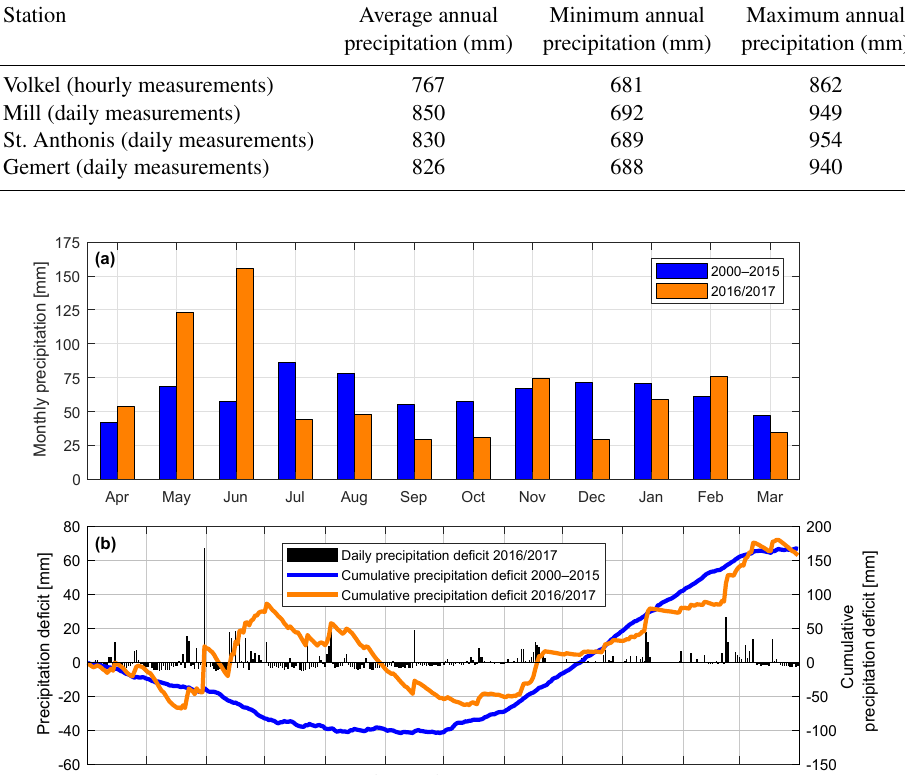
Figure 2. (a) Average monthly precipitation for the period 2000–2015 and the monthly precipitation in the hydrological year 2016 measured at Volkel weather station. (b) Daily and cumulative precipitation deficits for the period 2000–2015 and for the hydrological year 2016, based on precipitation measurements and reference evapotranspiration calculations at Volkel weather